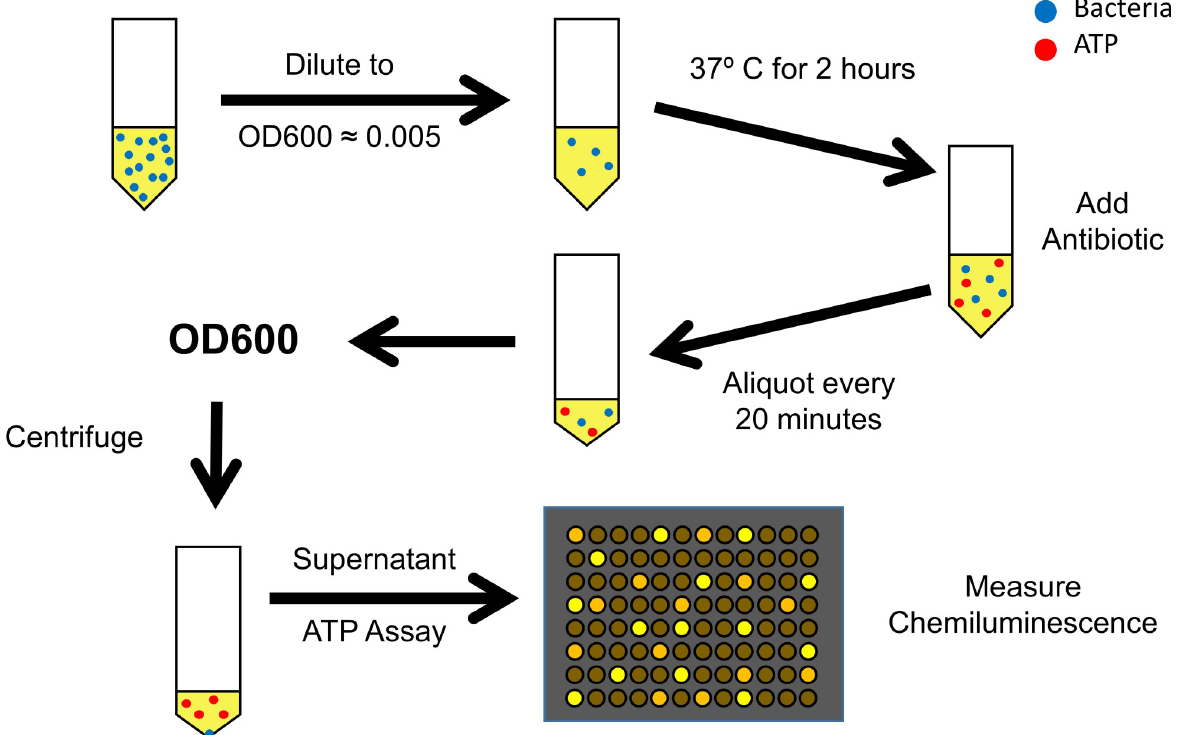
Fig 1. The overall procedure for the susceptibility assay. The overall assay procedure involves the growth of a single colony of bacteria overnight in selective media at 37˚C with shaking (not shown). The OD600 is measured and a diluted culture of 10 mL is prepared by dilution to an OD600 of approximately 0.005. After 2 hours of growth at 37˚C, 1 mL of the diluted culture is removed and the remainder of the diluted culture is mixed with the antibiotic to which the bacteria are susceptible. Aliquots are removed at 20, 40, and 60 minutes after adding the antibiotic for OD600 determination; next, each aliquot is centrifuged at 30,000 g for 30 seconds. The supernatant is transferred to a black bottom 96 well plate for the quantitative determination of ATP.